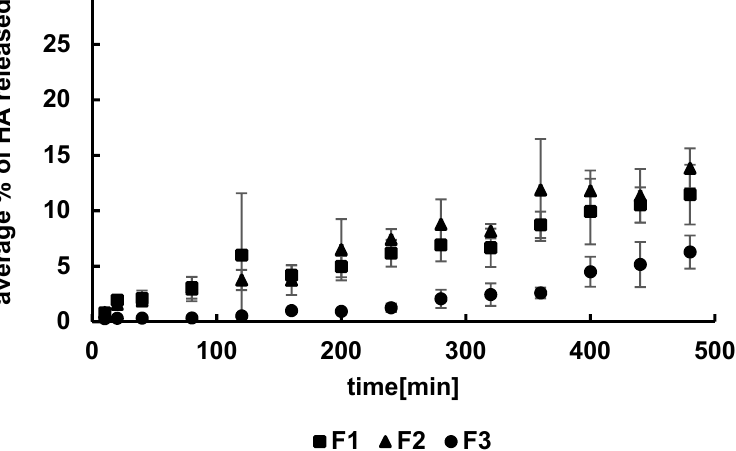
Figure 2. The release profiles of HA from formulations F1–F3.